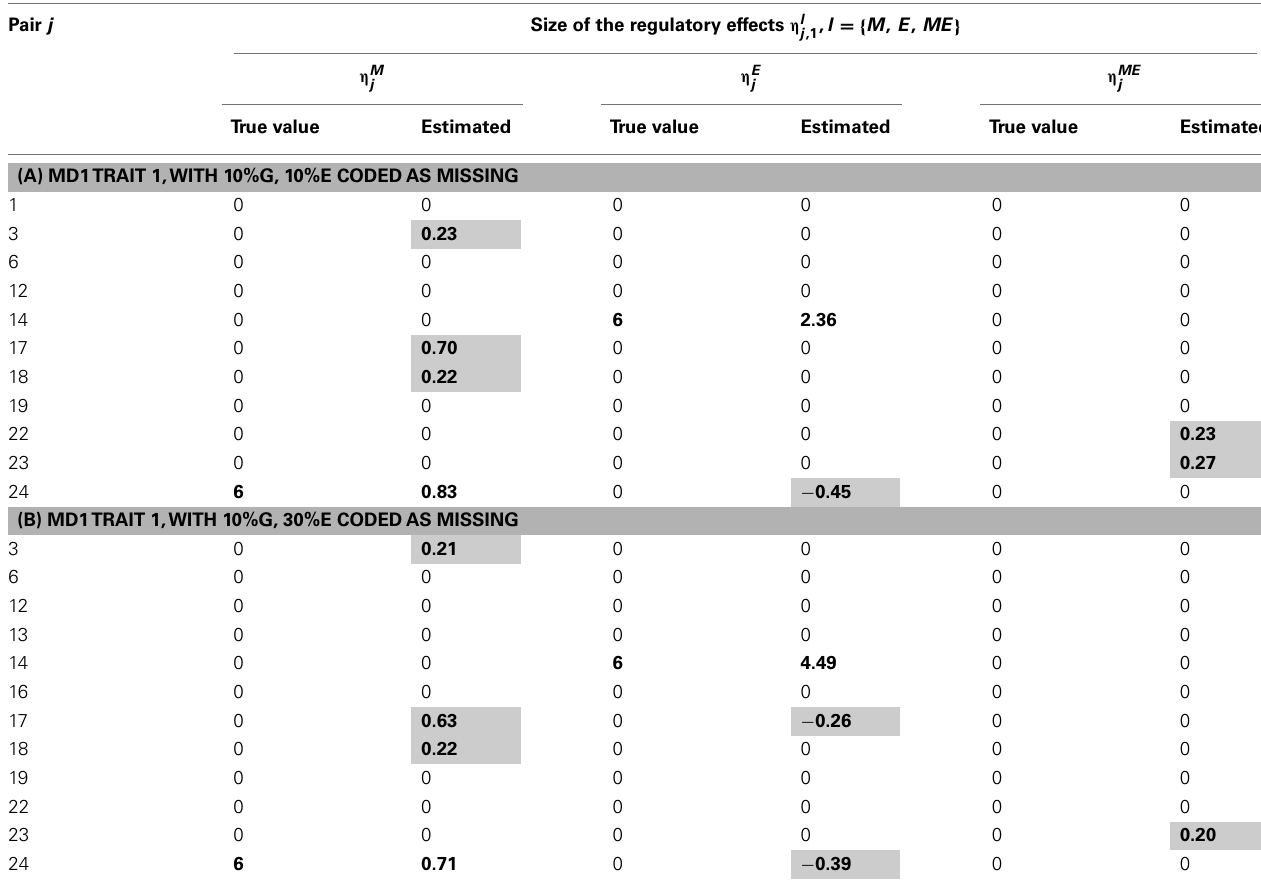
Table 8 |True and estimated (posterior means) cQTL effects in the analysis ofTrait 1 using the MD1 version of the HB single-trait cQTL model with (A) 10% markers and 10% expressions coded as missing and (B) 10% markers and 30% expressions coded as missing, and for s l = 0.09. Pair